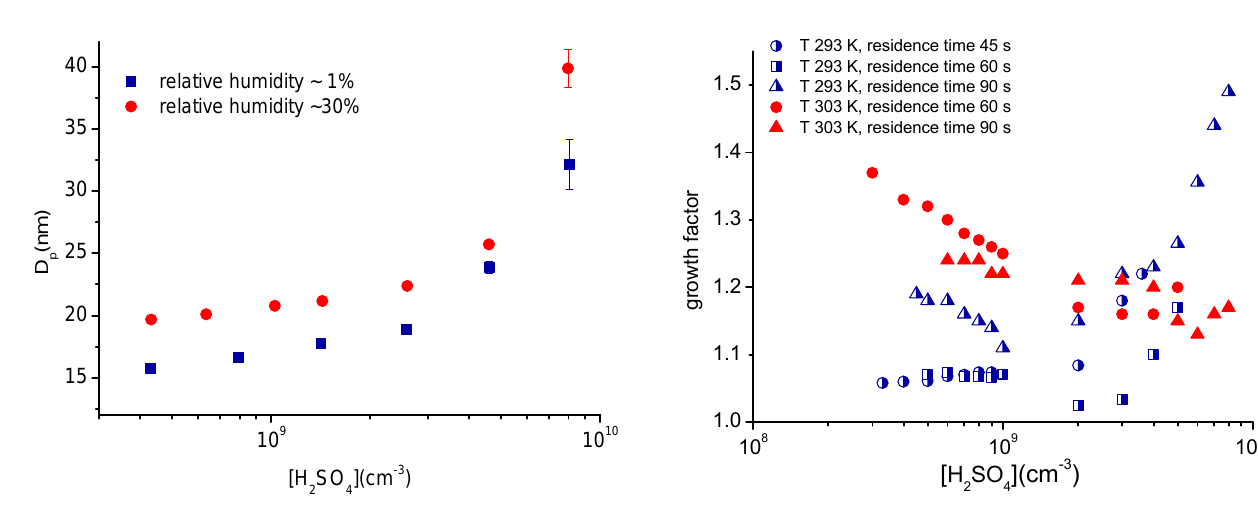
Figure 6. The variation in the median particle diameters determined from measurements performed at T = 303K, with a residence time of 60s and at different RH. The standard deviations of the median particle diameters are depicted as error bars.